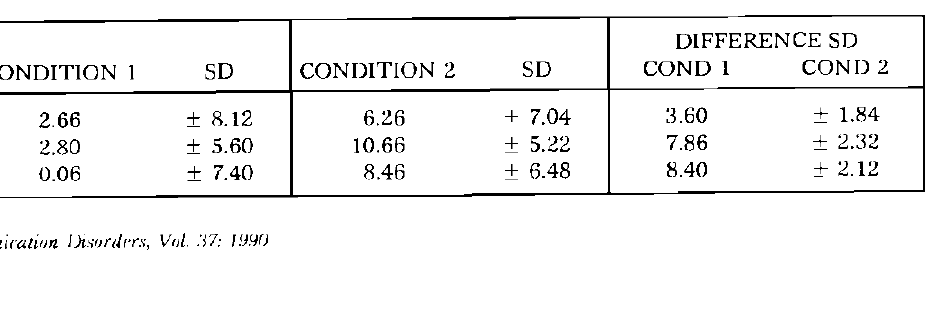
Table 3: Mean SRT in dB HL for male and female subjects in the study under Condition 1 (no guessing) and Condition 2 (guessing required). Difference values are also given. Standard deviations are